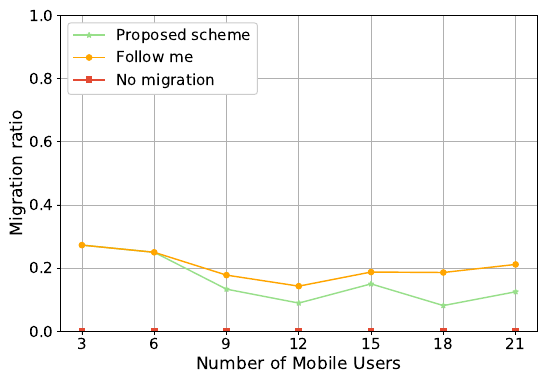
Figure 4. Comparison of the migration ratio with di(cid:27)erent number of users. The average user’s sojourn time is